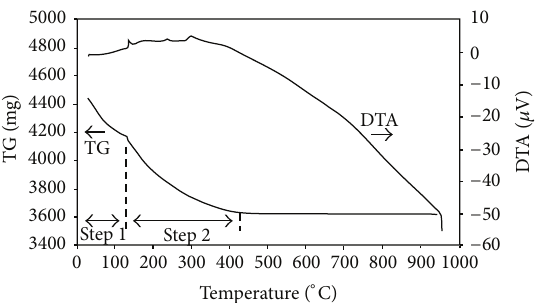
Figure 5: The thermogravimetry and differential thermal analysis of the dried colloidal titania gel.